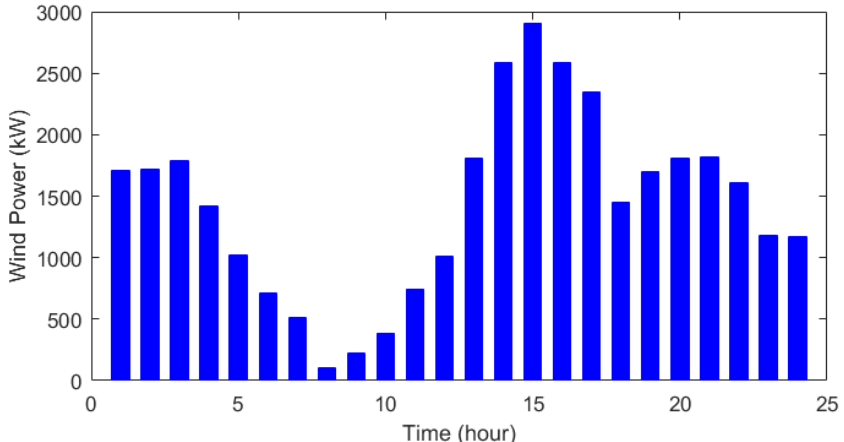
Figure 6. Wind power using the IGJO for 24 h.